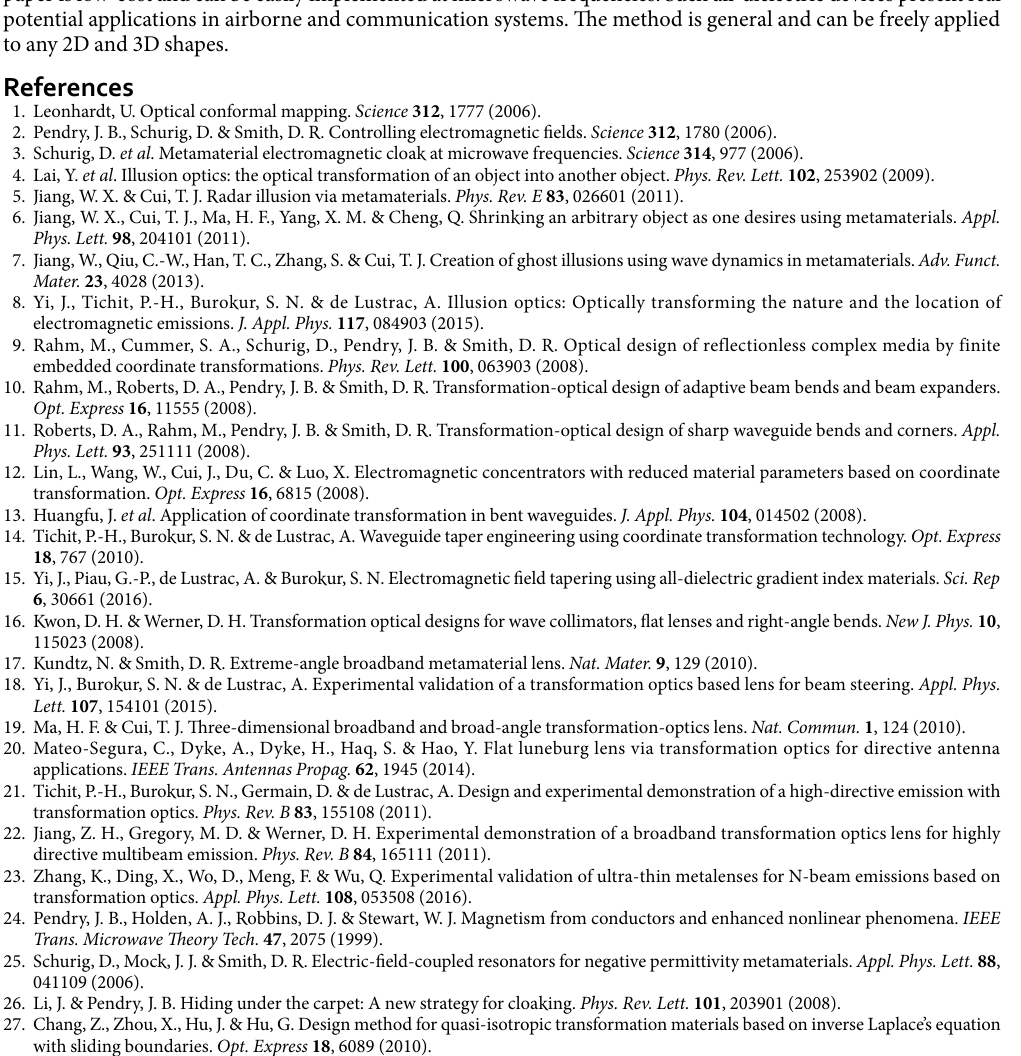
7 Scientific RepoRts | 7: 782 | DOI:10.1038/s41598-017-00681-z